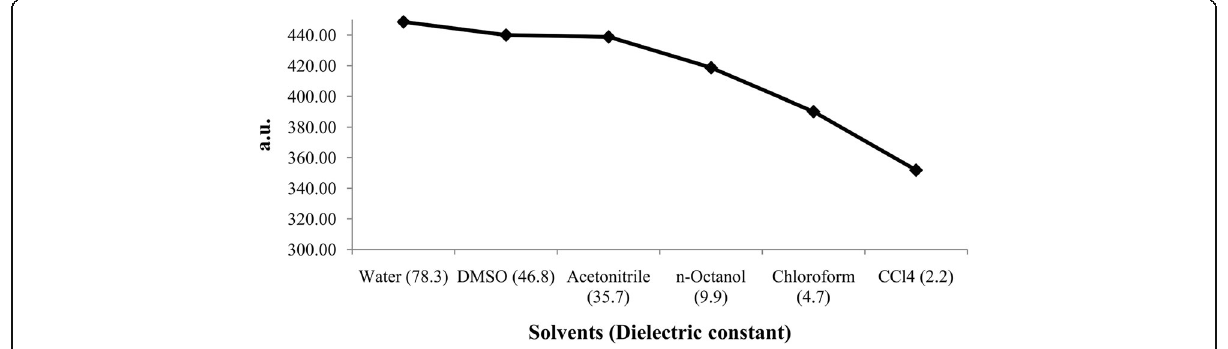
Fig. 9 Effect of solvent polarity on polarizability of betulinic acid